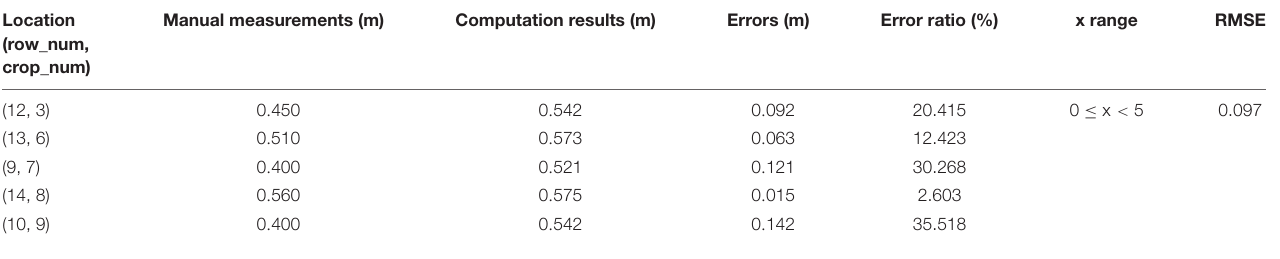
TABLE 7 | Plant height computation results for sub-area